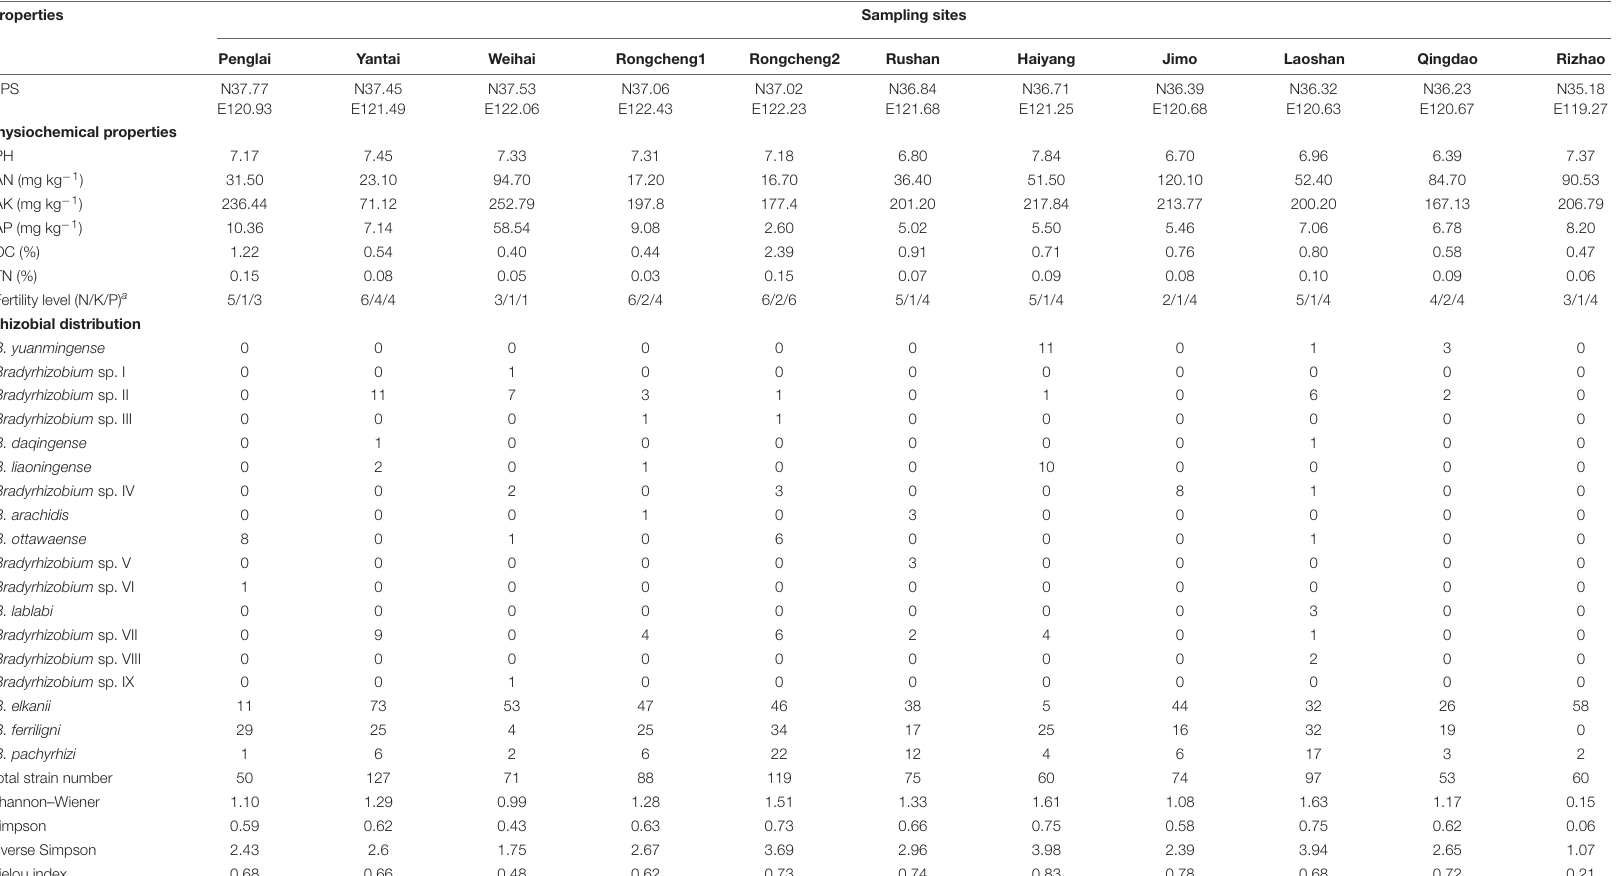
TABLE 1 | Relevant properties of soil samples and the distribution of different rhizobia genospecies.